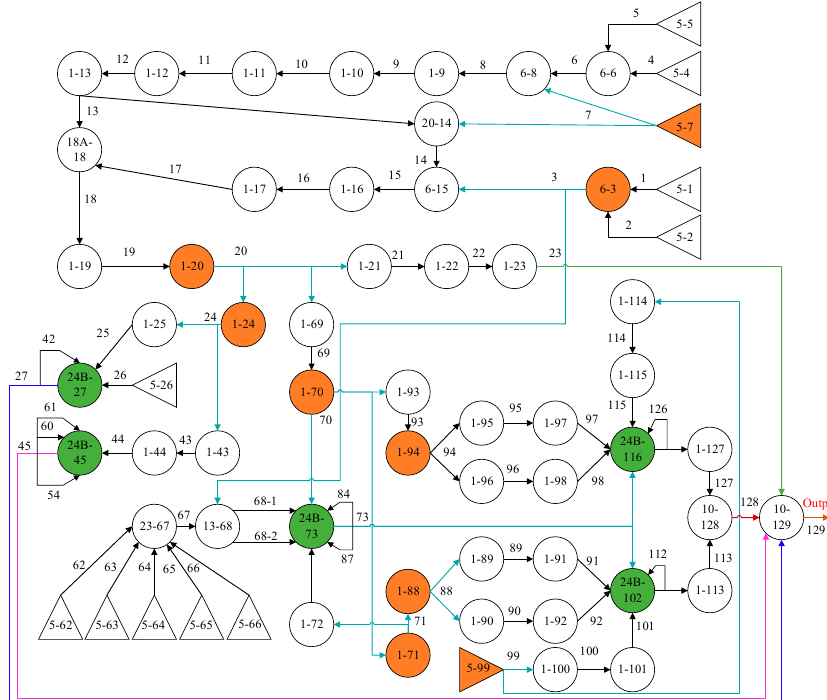
Figure 4. GO diagram model of the diesel engine system.